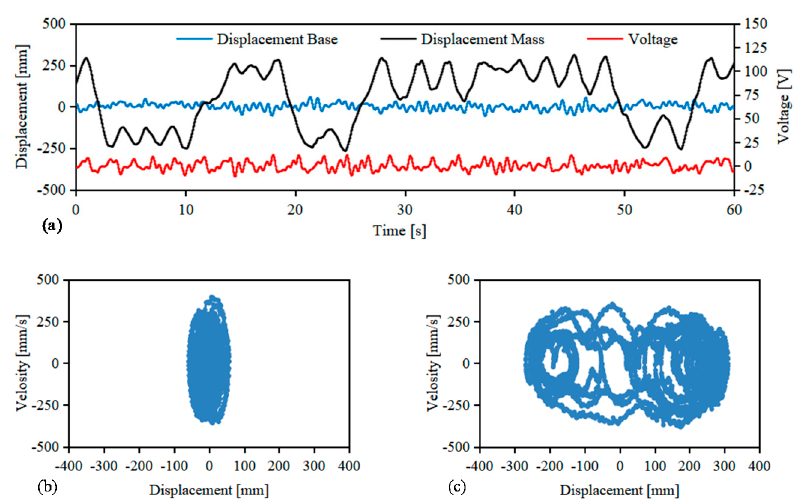
Figure 14. Measurement results of response vibration displacement and vibration power generation when vibrating with a random signal and a period signal 0.5 Hz. ( a ) Results of response vibration displacement. ( b ) Diagram of displacement velocity of vibration of the support. ( c ) Diagram of displacement velocity of vibration of the mass block.